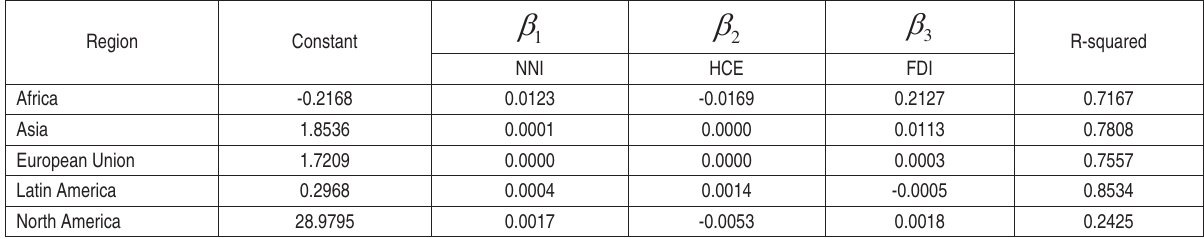
Table 5. Evaluation results between access expansion of credit unions’ services and financial and economic